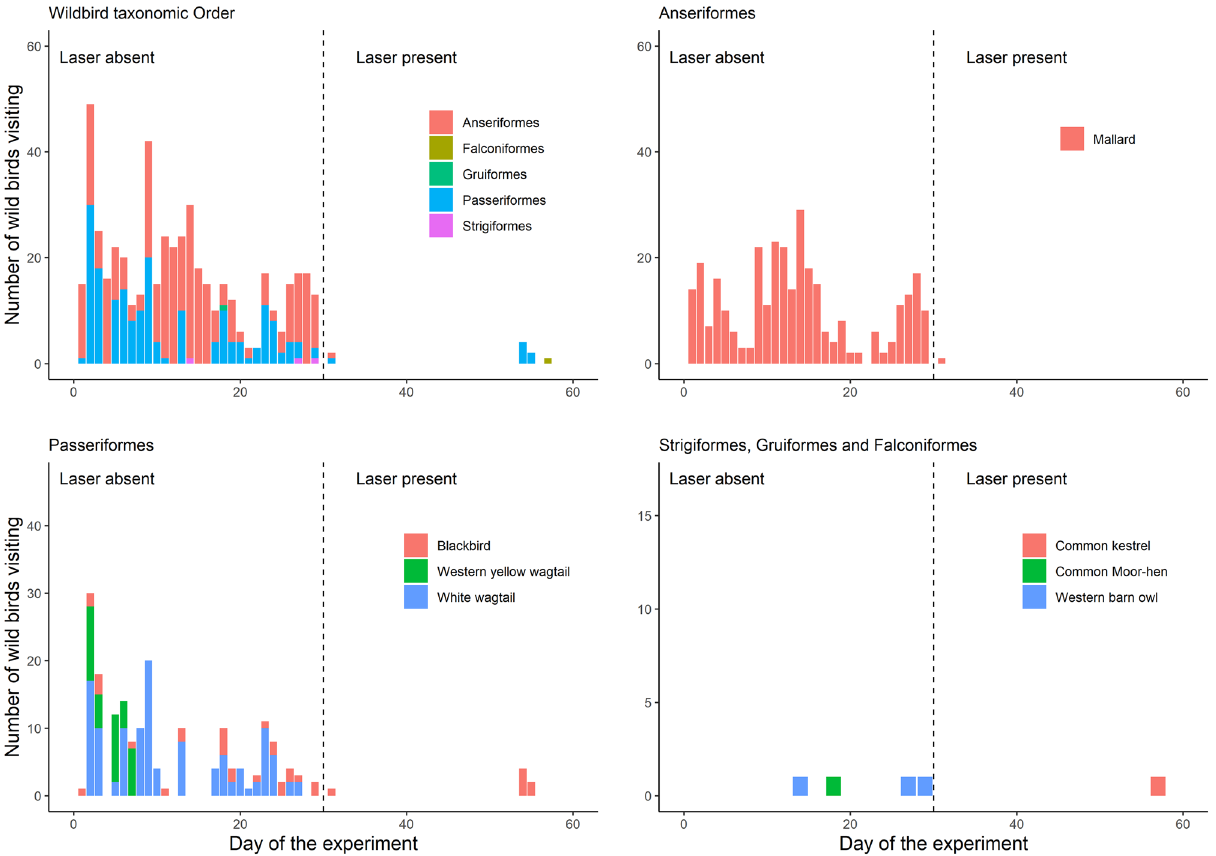
Figure 5. Number of wild birds visiting the free-range study area of the layer farm by observation day with and without the laser in operation; for all wild bird species together (upper left corner); for wild birds of the order Anseriformes (upper right corner); for wild birds of the order Passeriformes (lower left corner); for wild birds of the order Strigiformes, Gruiformes and Falconiformes grouped together (lower right corner).